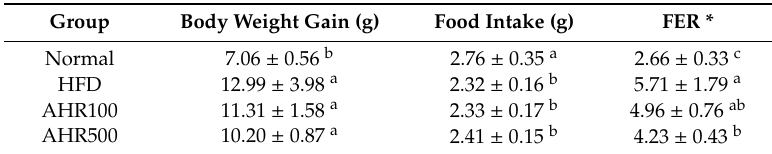
Figure 2. Effects of AHR on body weight changes and fat weight in high-fat diet (HFD)-induced obese mice. Body weight ( A ) was measured during 9 weeks. Abdominal ( B ) and epididymal ( C ) fat weights are shown. Data are expressed as mean ± SEM ( n = 6–8). Values with different letters are significantly different at p < 0.05. Table 4. Effect of AHR on body weight, food intake, and feeding efficiency ratio (FER) in HFD-induced mice.